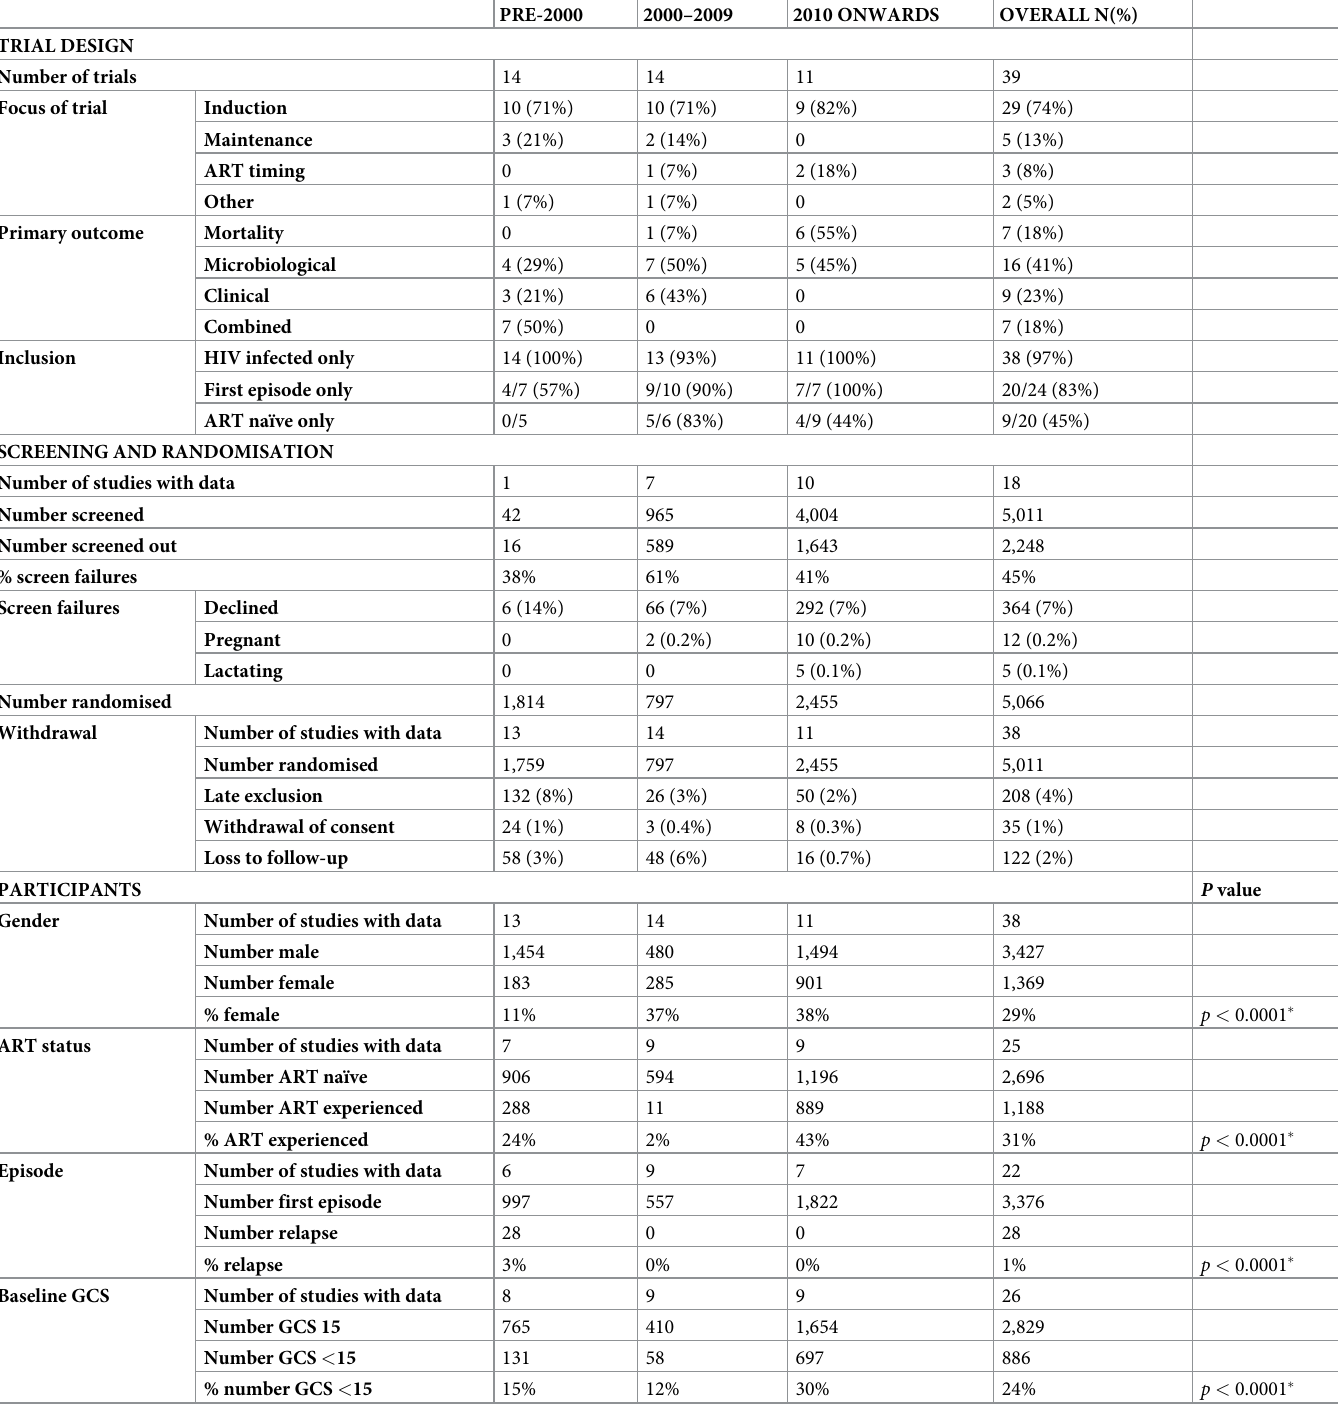
Table 3. Characteristics of HIV-associated cryptococcal meningitis trials within different time periods and overall. Where data were not available, the number of tri- als with available data is presented as a